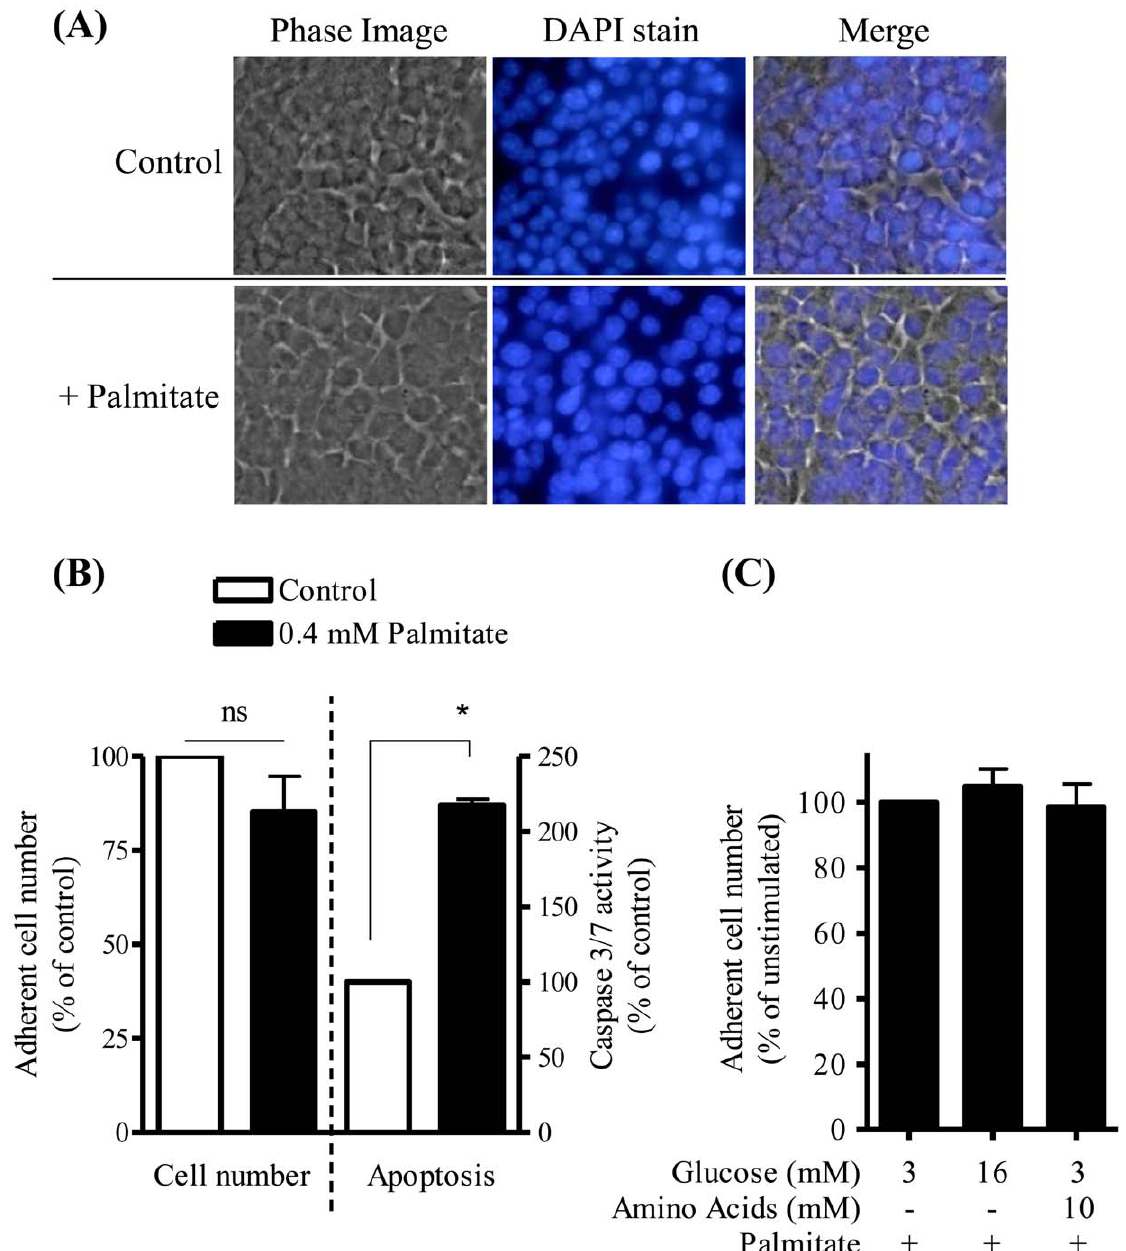
Figure 2. Effects of palmitate on MIN6 b cell number and apoptosis. MIN6 b cells were incubated in the absence or presence of palmitate (0.4 mM) for 48 h prior to analysis of cell number by DAPI staining (A) or (B) caspase 3/7 activity (a proapoptotic marker). Three random visual fields from duplicate samples were chosen (typical phase, DAPI stained and merged images are shown in panel A), and adherent cell number noted from control or palmitate-treated cells following DAPI staining (A and B). Alternatively, following the fatty acid incubation period cells were incubated with caspase 3/7 assay reagent and caspase 3/7 activity determined by luminescence as described in methods (B). In some experiments, cells that had been pre-treated with palmitate (0.4 mM, 48 h) were subsequently incubated with glucose (16 mM) or with an amino acid/glucose mix (10 mM leucine and glutamine/3 mM glucose) for 1 h prior to analysis of cell number by DAPI staining (C). Bar values are mean 6 SEM from 3 or 4 separate experiments. The asterisk signifies a significant difference from the appropriate control value (P ,